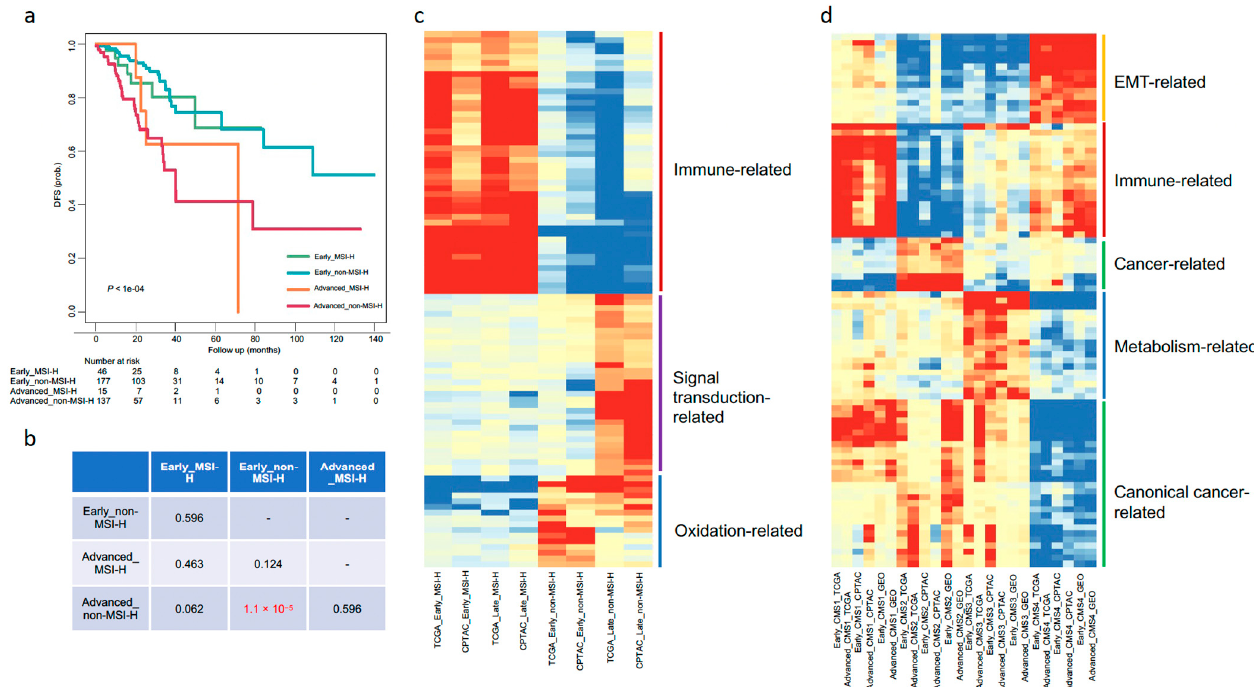
Figure 2. Stage_MSI and Stage_CMS molecular and clinical implications. ( a ). Kaplan–Meier survival curve comparing DFS of the four groups (Early_MSI-H, Early_non-MSI-H, Advanced_MSI-H, and Advanced_non-MSI-H) in the TCGA cohort. The indicated p -value was calculated with the log-rank test. ( b ). Summary table of the pairwise comparisons of survival curves between the four groups. Survival difference was tested using the log-rank test, with FDR adjusted p -values less than 0.05 were considered statistically significant and displayed in red color. ( c ). A p -value heatmap representing dysregulated gene sets between early_MSI-H, early_non-MSI-H, advanced_MSI-H, and advanced_non-MSI-H groups. ( d ). A p -value heatmap representing dysregulated gene sets between CMS 1-4 (in early stage) and CMS 1-4 (in advanced-stage) groups. In the heatmaps, columns correspond to different groups, and rows to gene sets. Values in the heatmaps were − log10 (FDR adjusted p -value) transformed. Red color indicates up-regulated gene sets, and green means down-regulated gene sets in the corresponding groups. Gene sets were grouped into different functional categories, with representative functional names shown on the right hand of the heatmaps accompanied by a colored line, respectively (such as maroon for immune-related, orange for EMT-related, and blue for metabolism-related gene sets).